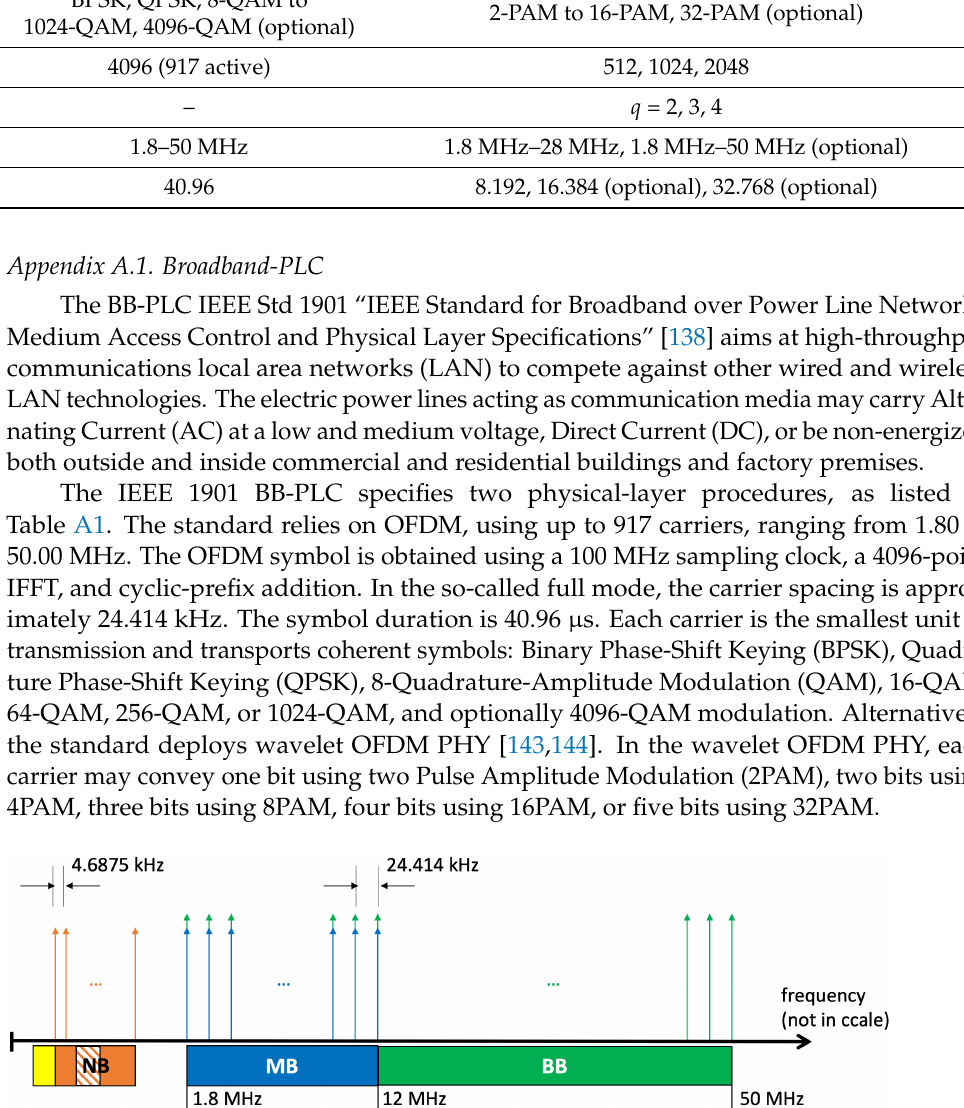
Forward Error Correction